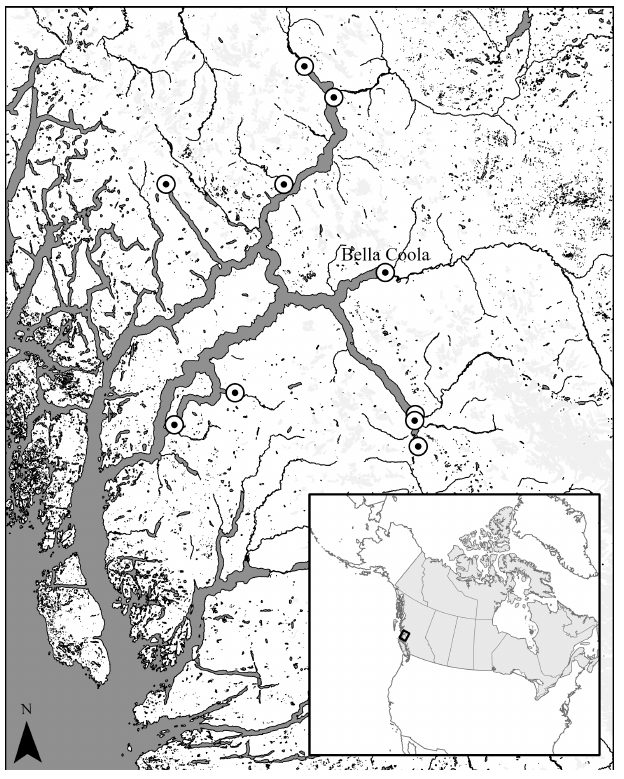
Fig. 1 . Nuxalk eulachon ( Thaleichthys pacificus ) rivers: black dots indicate rivers where eulachon were historically harvested by Nuxalkmc and/or where significant eulachon runs are known to have occurred in Nuxalk